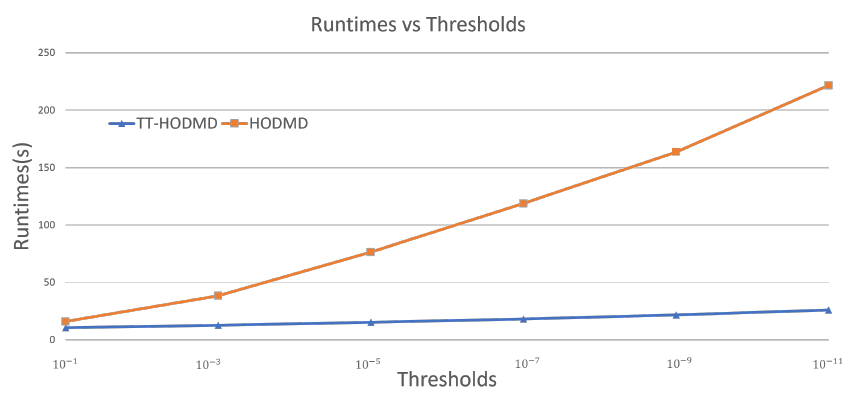
Figure 7. Eigenvalues with d = 400.